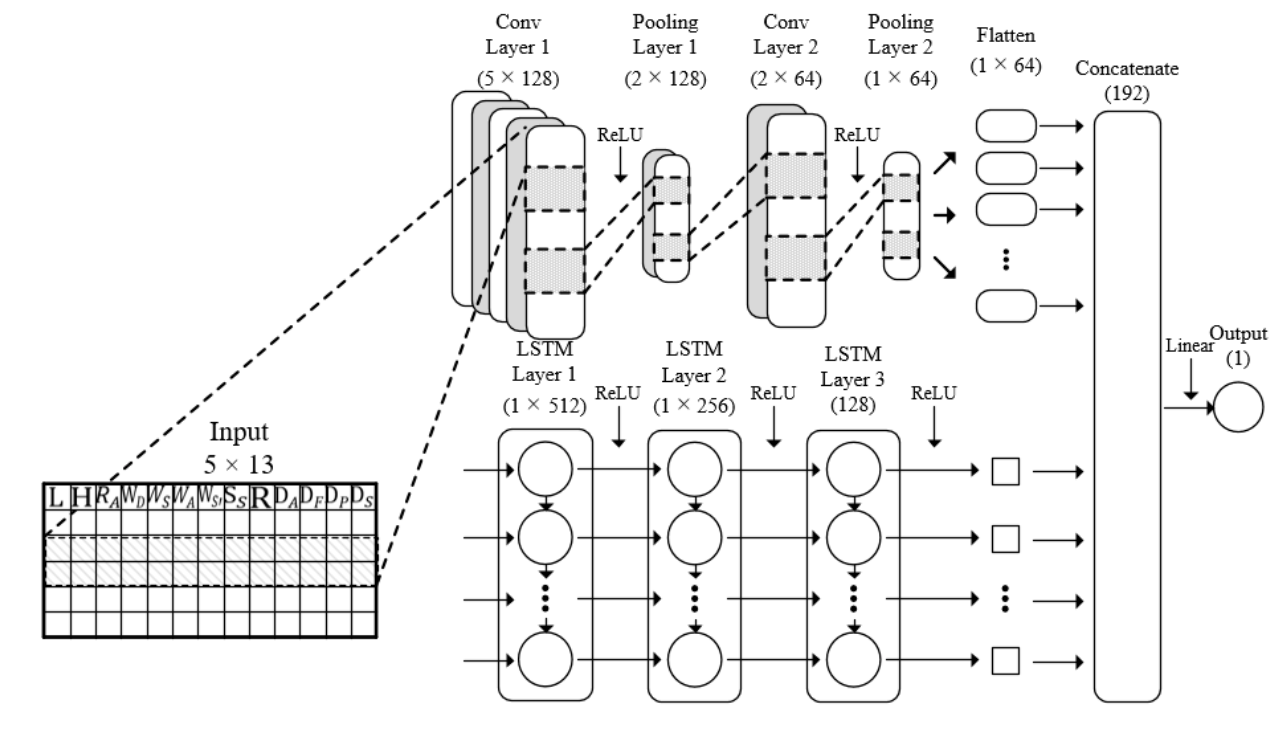
Figure 3. Construction of CNN–LSTM (parallel).